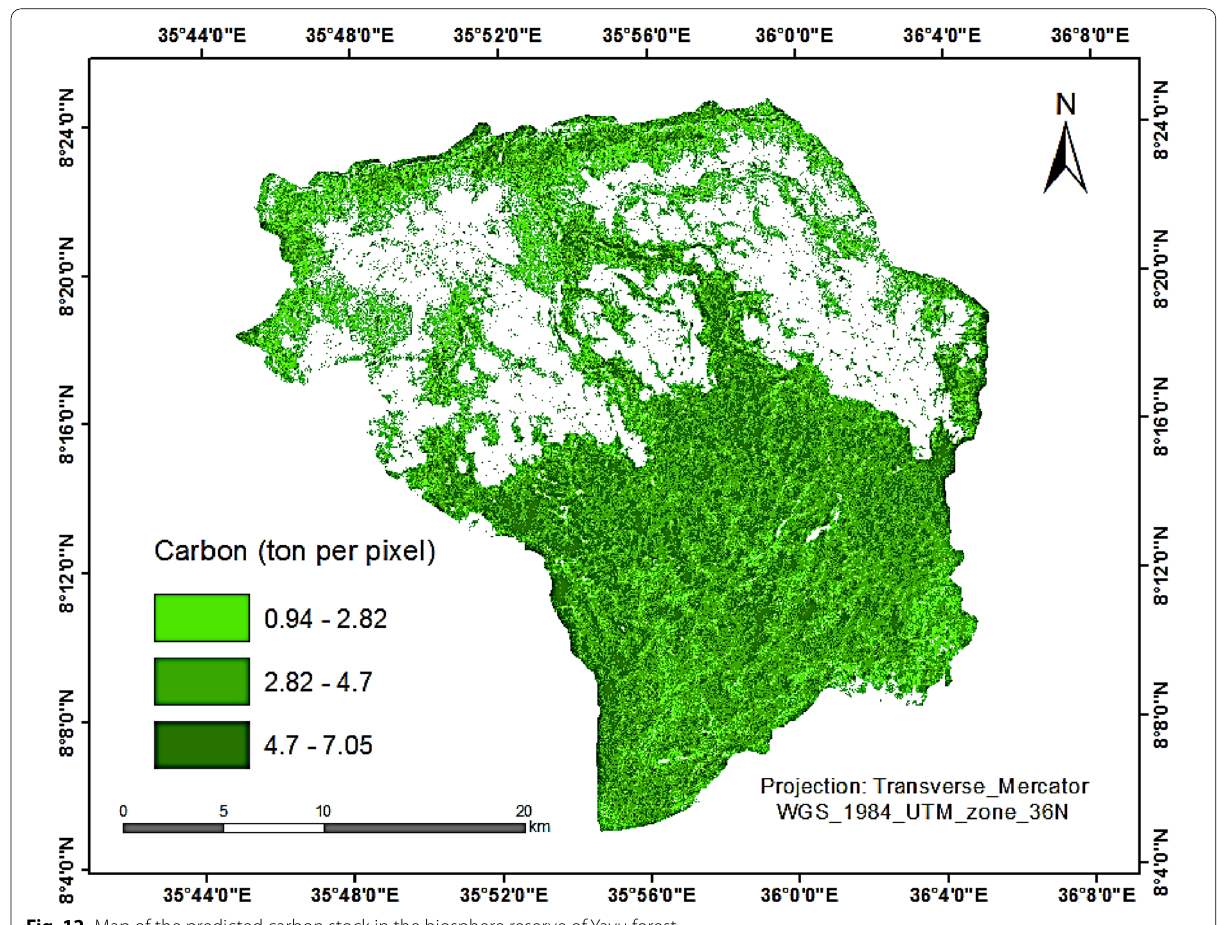
Fig. 12 Map of the predicted carbon stock in the biosphere reserve of Yayu forest